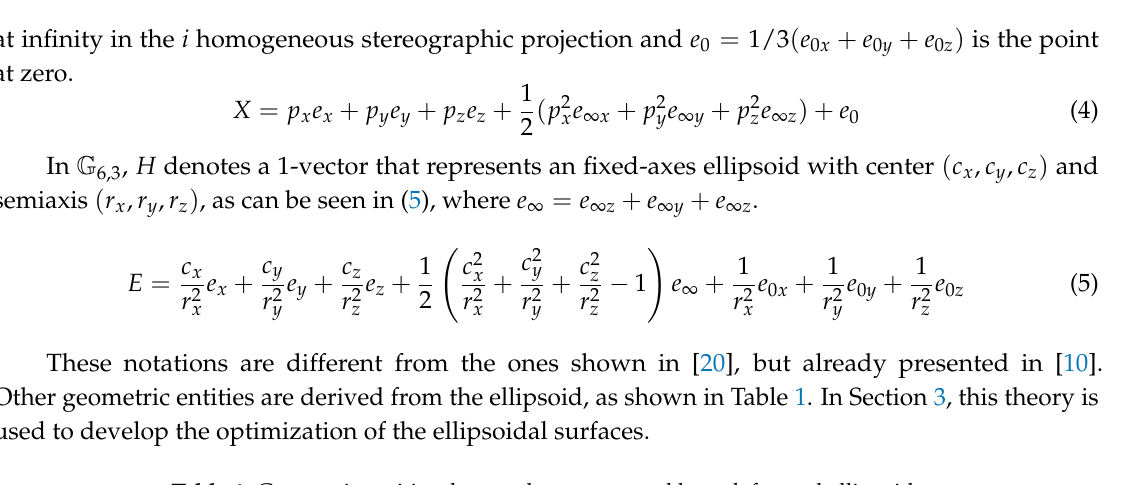
Table 1. Geometric entities that can be represented by a deformed ellipsoid.